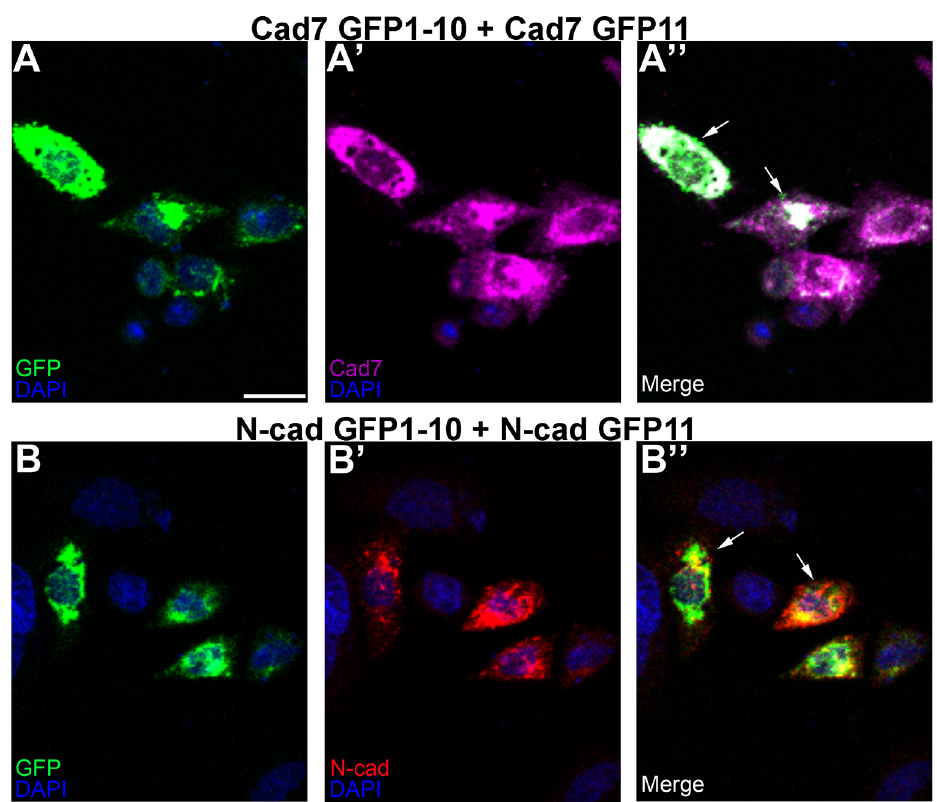
Figure 5. Identical cadherin-expressing GRASP constructs possessing complementary GFP domains reconsti- tute GFP in cis. CHO cells were co-transfected with complementary split GFP constructs expressing the same cadherin (Cad7 GFP1-10 and Cad7 GFP11 (A-A ” ); N-cad GFP1-10 and N-cad GFP11, (B-B ” )), followed by immunocyto- chemistry for Cad7 (A ’ , A ” , purple) or N-cad (B ’ , B ” , red). GFP fluorescence was also examined in the appropriate microscope channel (488, A, A ” , B, B ” , green). Arrows point to GFP fluorescence in transfected cells, indicative of physicalinteractionsbetweeneachsplitGFP-expressingcadherin.DAPI(blue),cellnuclei.Scalebarin(A)is50 μ mand applies to all images. N=8 replicates for both treatments. GFP, green fluorescent protein; GRASP, GFP reconstitution across synaptic partners; CHO, Chinese hamster ovary; N-cad, neural cadherin; Cad7,